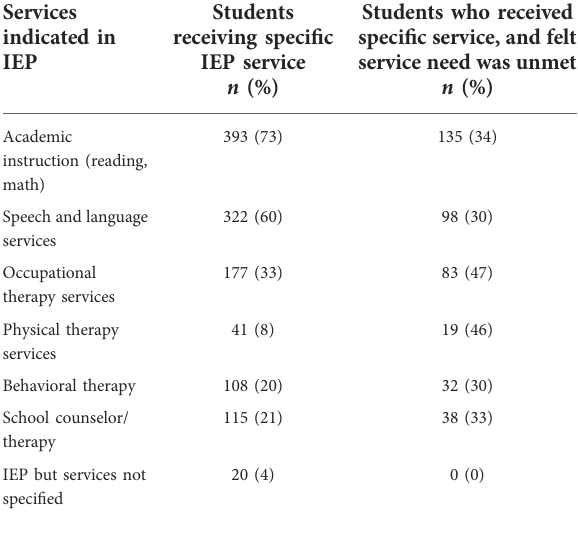
TABLE 1 Attested frequency change of special education and related services during the COVID-19 pandemic (total students with IEP: n